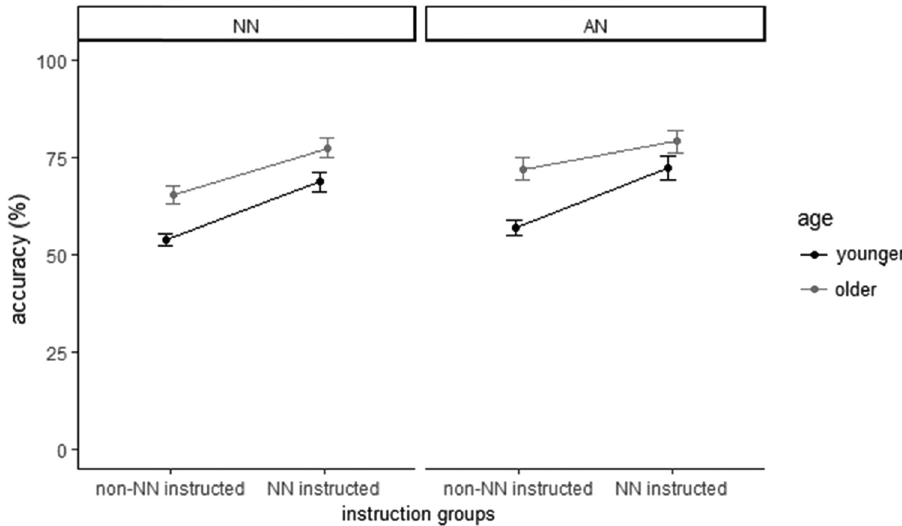
Figure 8: Correct judgments in the two NN instructed groups: NN compounds versus AN strings.